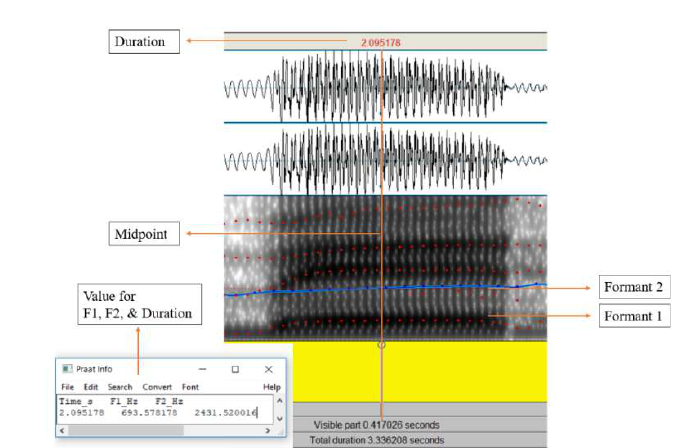
Figure 4. Example of formant measurements